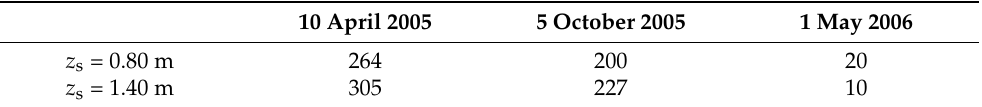
Figure 10. Comparison between the rainfall event recorded on 1 May 2006 and the critical curve calculated at the depth of 0.80 m. Table 3. Values of the critical duration d c (in hours) calculated considering the initial suction existing before the considered rainfall events.